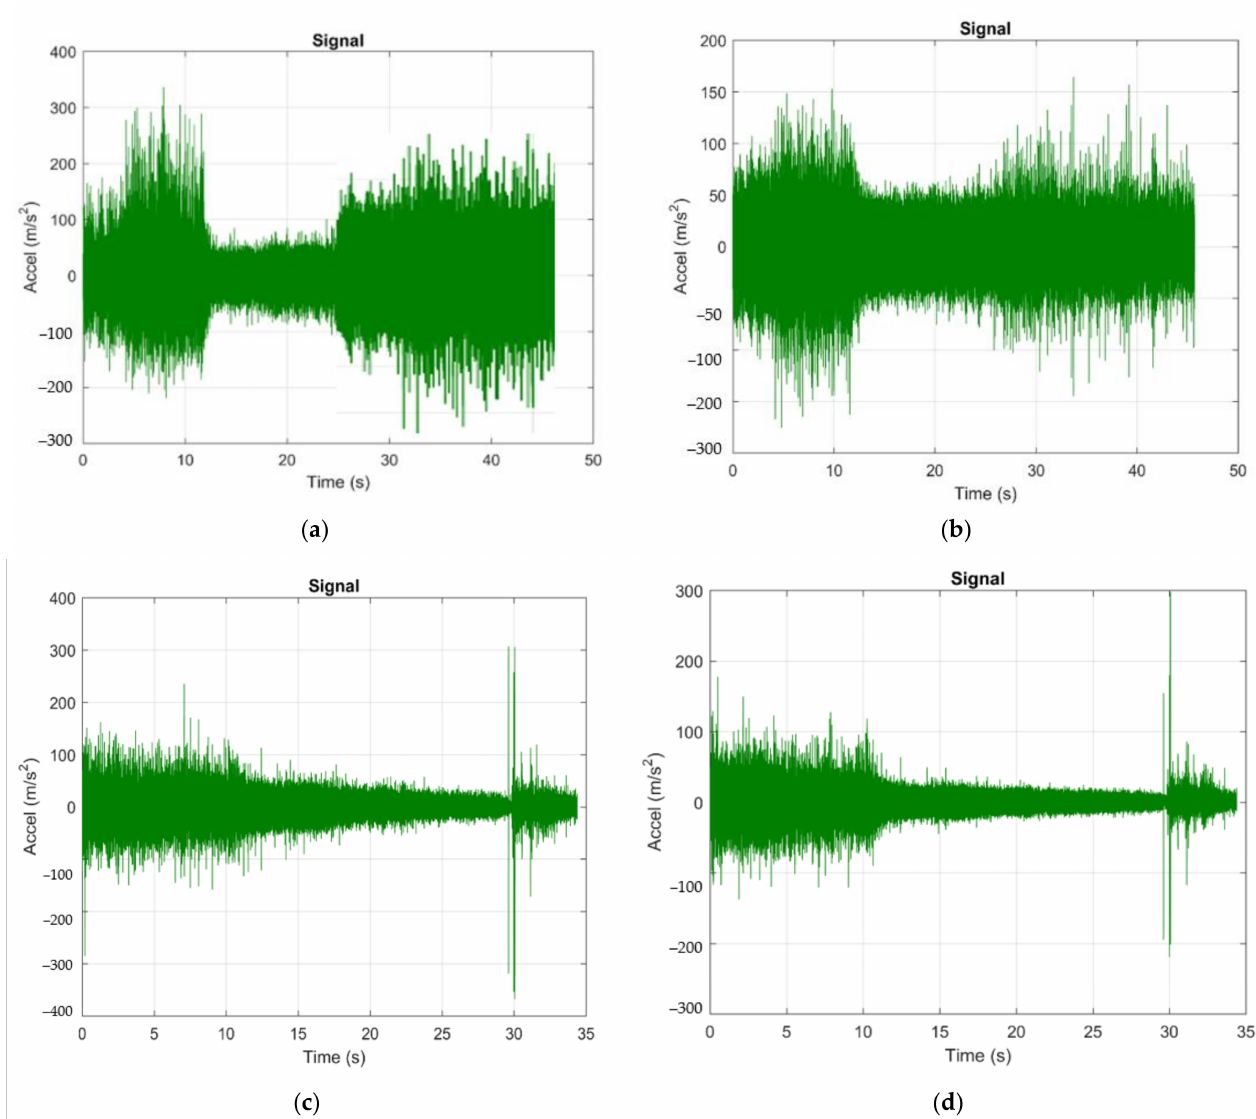
Figure 8. Acceleration of vibrations recorded during machining: ( a ) in the Z direction in the case of machining with a cutting tool T01; ( b ) in the Y direction in the case of machining with a cutting tool T01; ( c ) in the Z direction in the case of machining with a T02 cutting tool; ( d ) in the Y direction in the case of machining with a cutting tool in variant